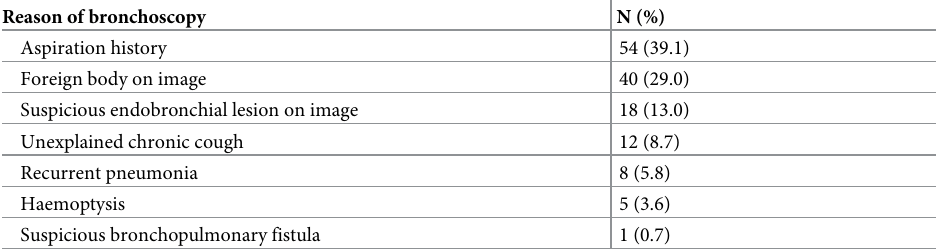
Table 3. The indication of